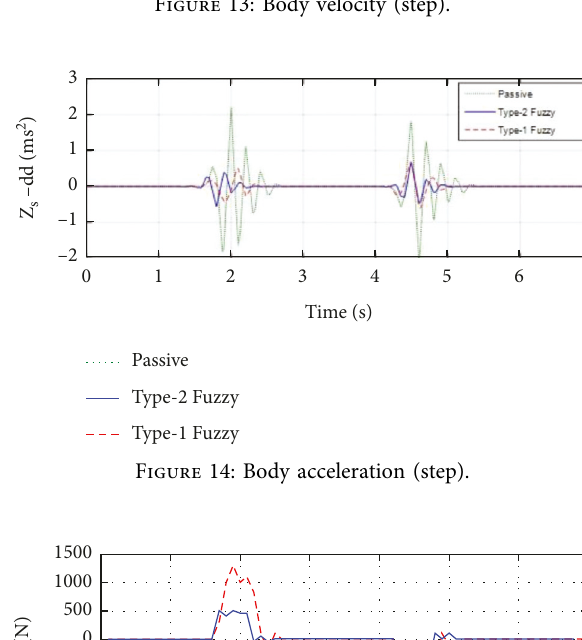
Figure 13: Body velocity (step).